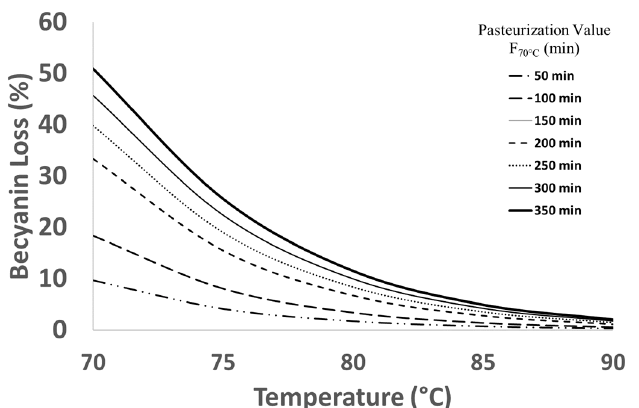
Figure 2. Estimated betacyanin losses during isothermal treatments of cactus pear juice with varied setup temperatures and different F 70 °C values using the Ball model.